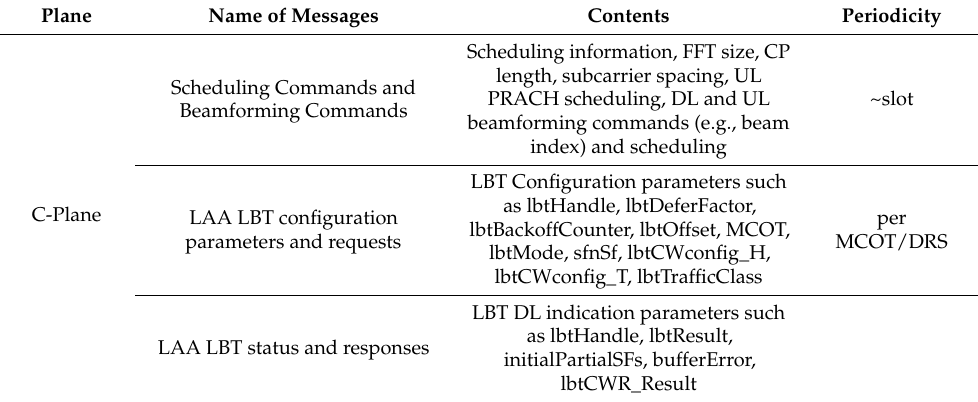
Table 1. Data flow information mapping between O-DU and O-RU (Source: O-RAN Alliance).